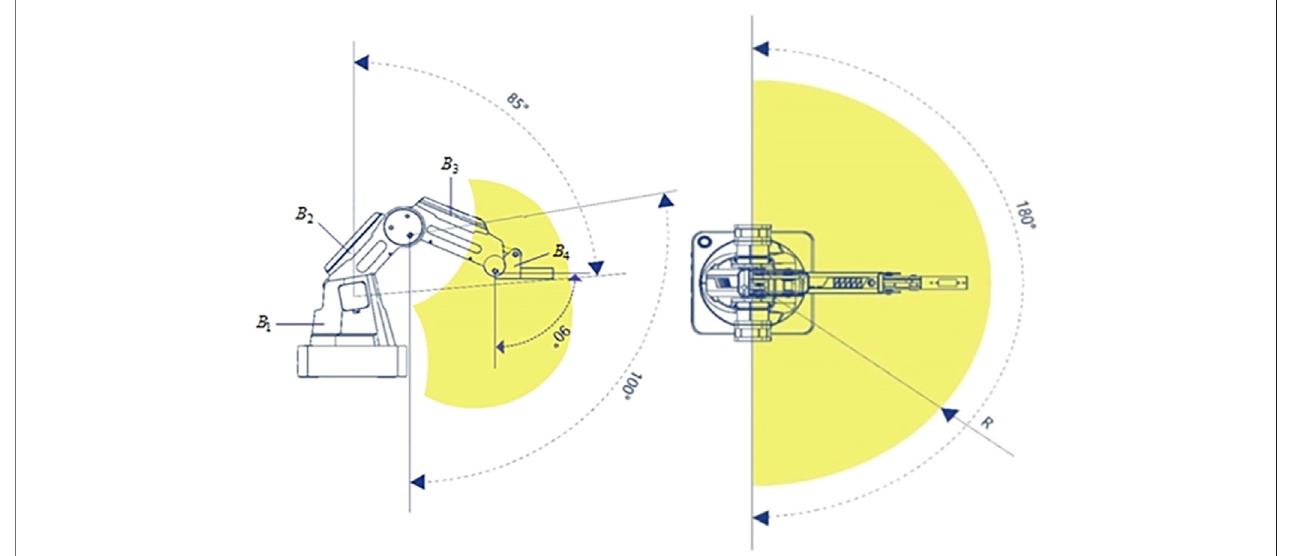
FIGURE 1 | Working space of the four degrees-of-freedom assembly manipulator.